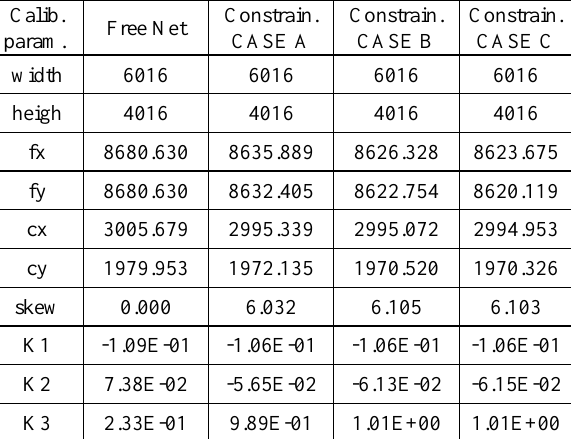
Table 9. Camera calibration parameters calculated by